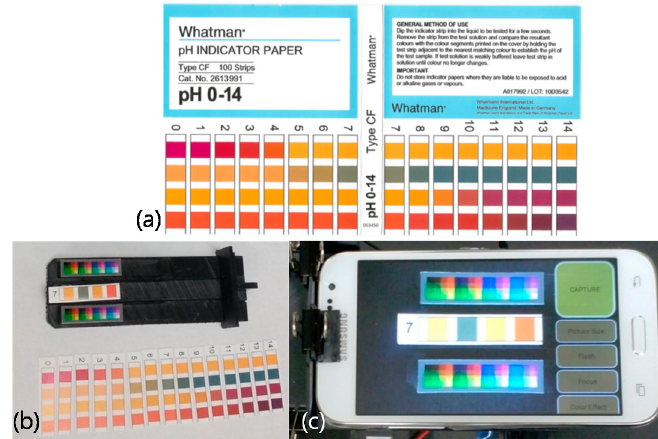
Figure 5. Preparations for calibration step: ( a ) Paper-printed comparison chart; ( b ) Split pieces; ( c ) Capturing the pieces on the mini light box.